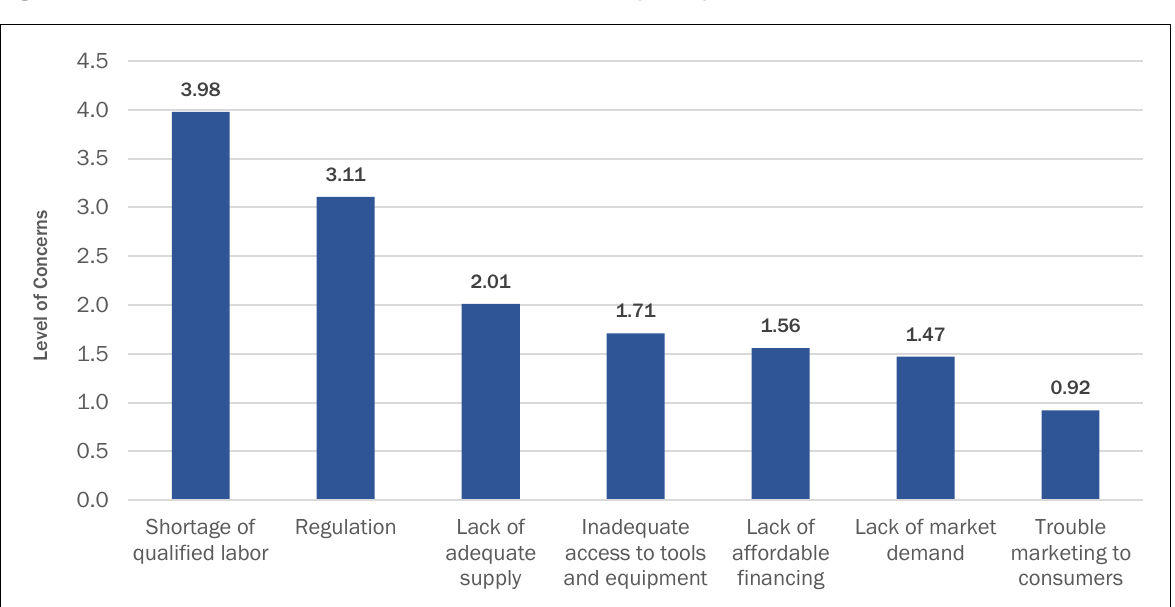
Figure 6. Meat Processors ’ Concerns for Their Businesses ( N =26)